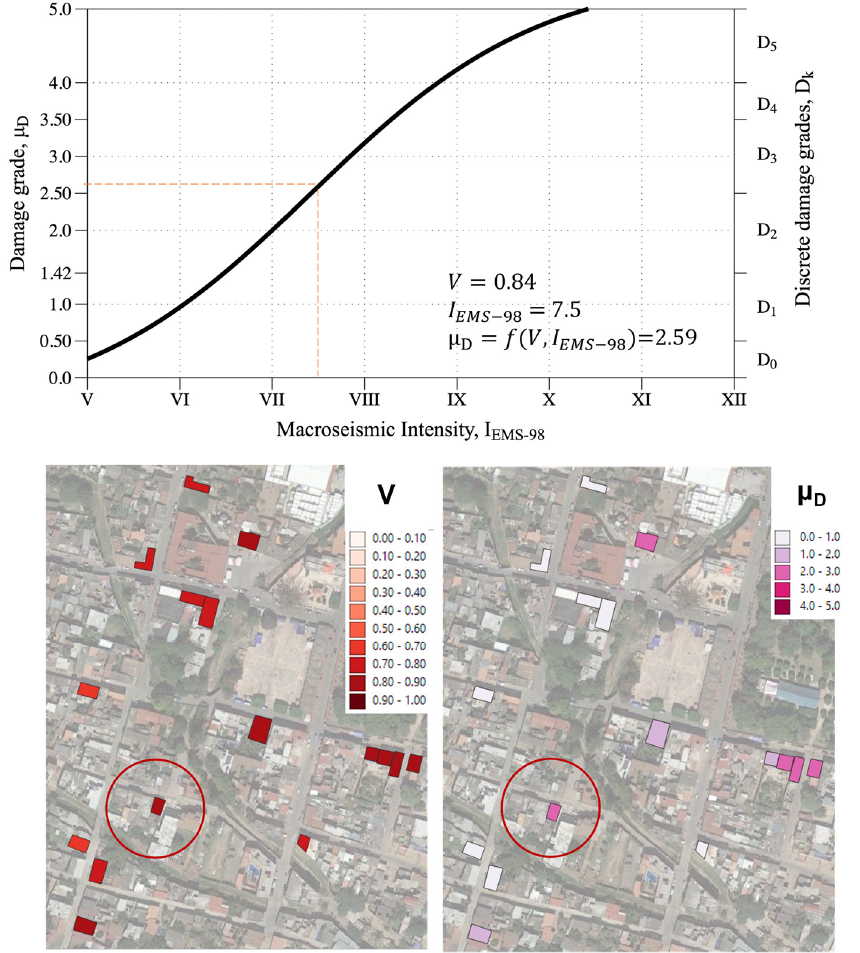
Figure 5. Damage curve based on the values obtained from the seismic vulnerability calculator ( top ) and visual representation of the levels of vulnerability (V) and mean damage grade µ D by using the GIS environment ( bottom ).